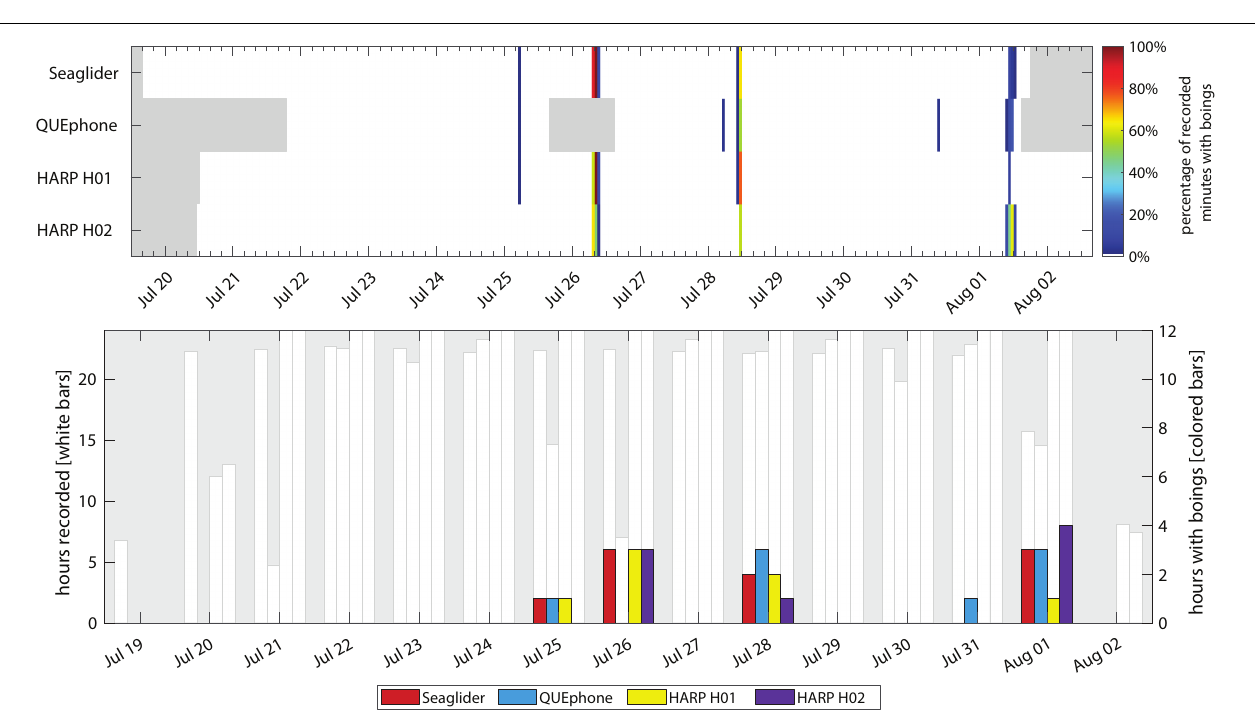
FIGURE 6 | Daily presence of delphinid vocalizations (whistles and clicks) by recording platform. White bars and left y -axis indicate the total hours recorded per day by each platform. No white bar indicates a day where that recorder was either not deployed or not yet recording. Colored bars and right y -axis indicate hours per day with delphinid clicks or whistles present.